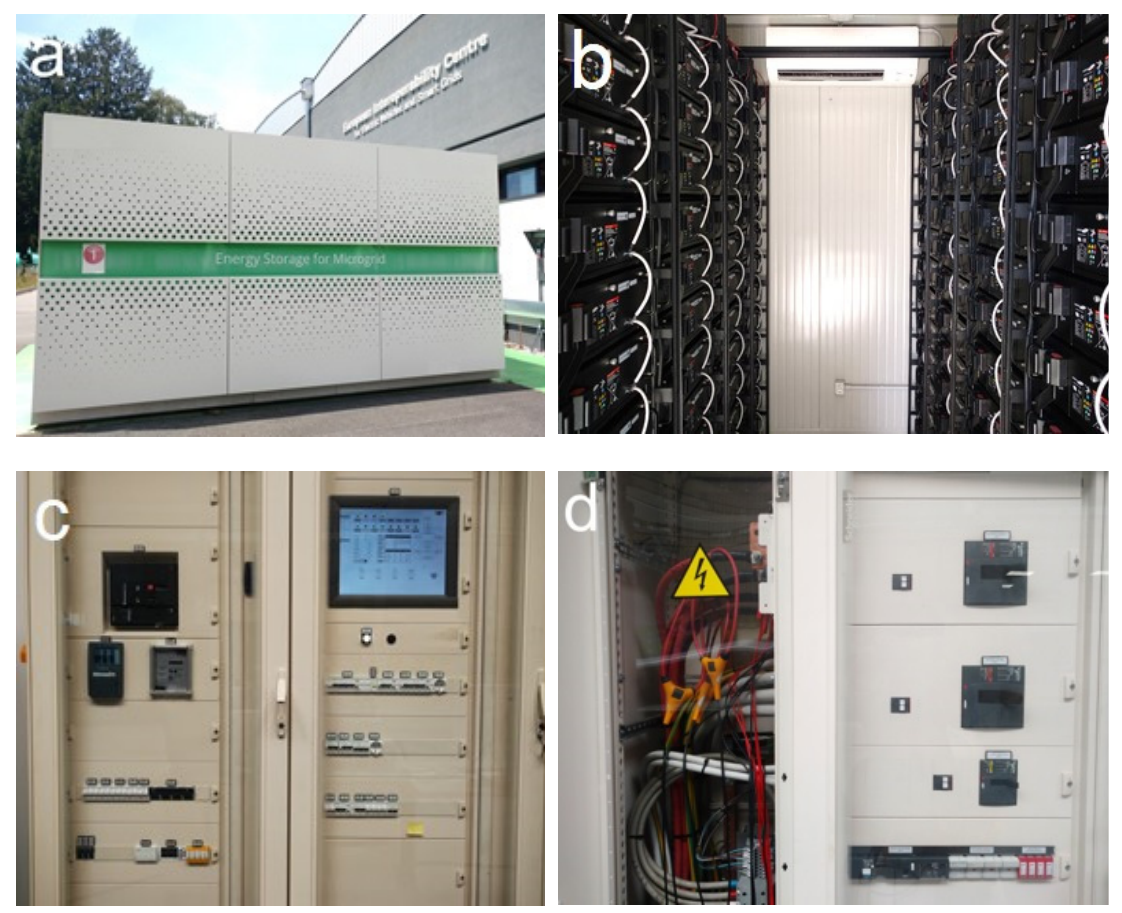
Figure 2. The BESS setup: battery container ( a ) , racks ( b ) , SCADA ( c ) , switchboard and feeder ( d ).